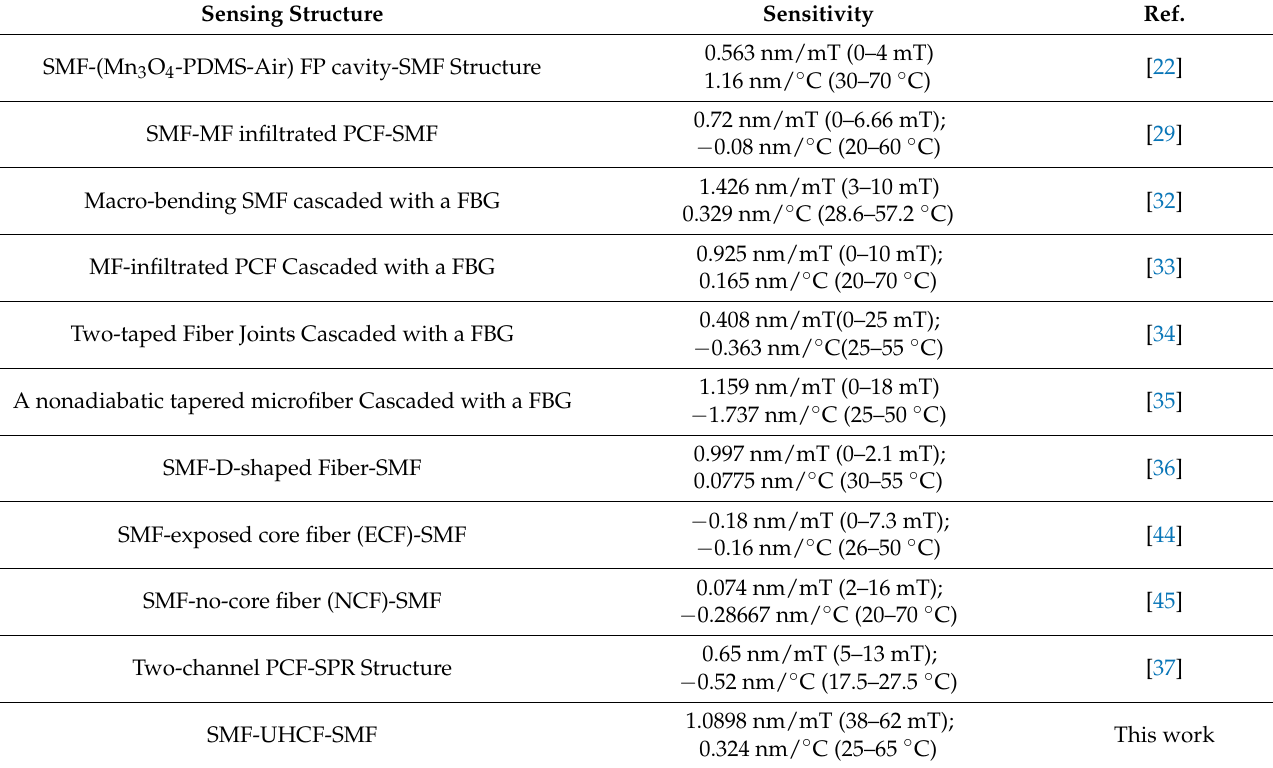
Table 1. Comparison with some other dual-parameter sensors of magnetic field and temperature. Sensing